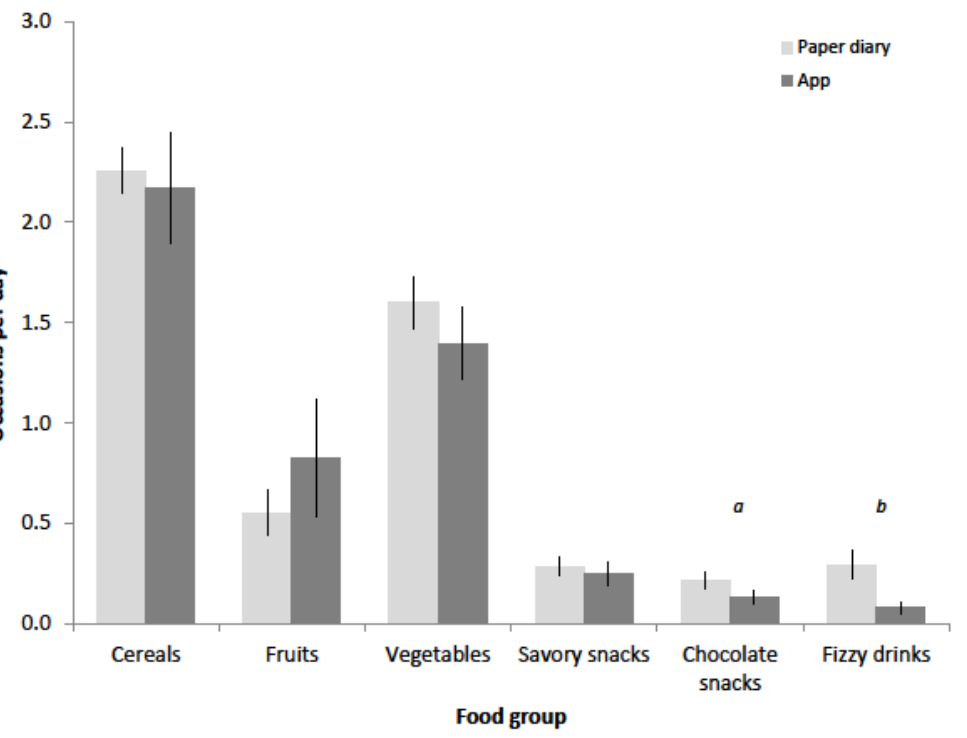
Figure 2. Analysis of records per food group for the paper diary and app. Data are expressed as an average per day on which a total >500 kcal was recorded. Errors are expressed as standard error of the mean (SEM, n= 32). There is a significant difference between the use of paper diaries and the app in the recording of chocolate snacks and fizzy drinks (a: P =.012; b: P